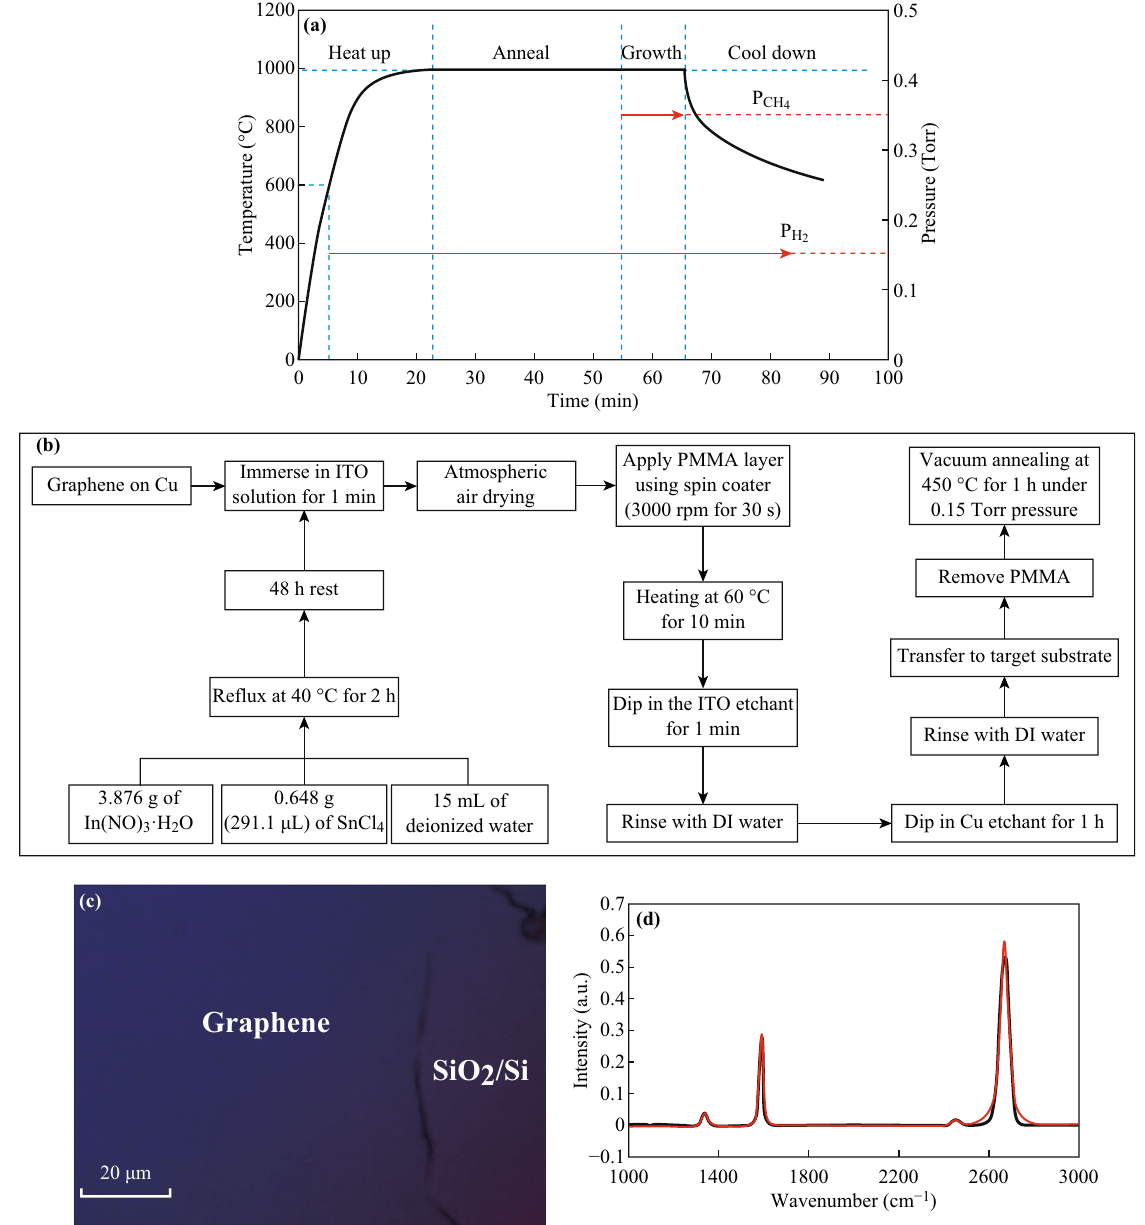
Fig. 1 a Schematic of the CVD graphene growth process. b Process flow chart of the synthesis of ITO nanoparticles/graphene hybrids. c Optical microscopic image of graphene on SiO 2 (300 ± 5 nm)/Si substrate. d Raman spectrum of CVD graphene (excitation wavelength of 532 nm) on SiO 2 (300 ± 5 nm)/Si (black line) and Lorentzian fitted curve (red line). (Color figure